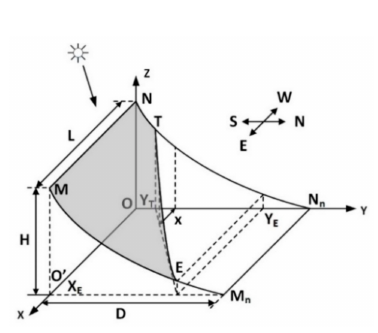
Figure 4. Case (ii).